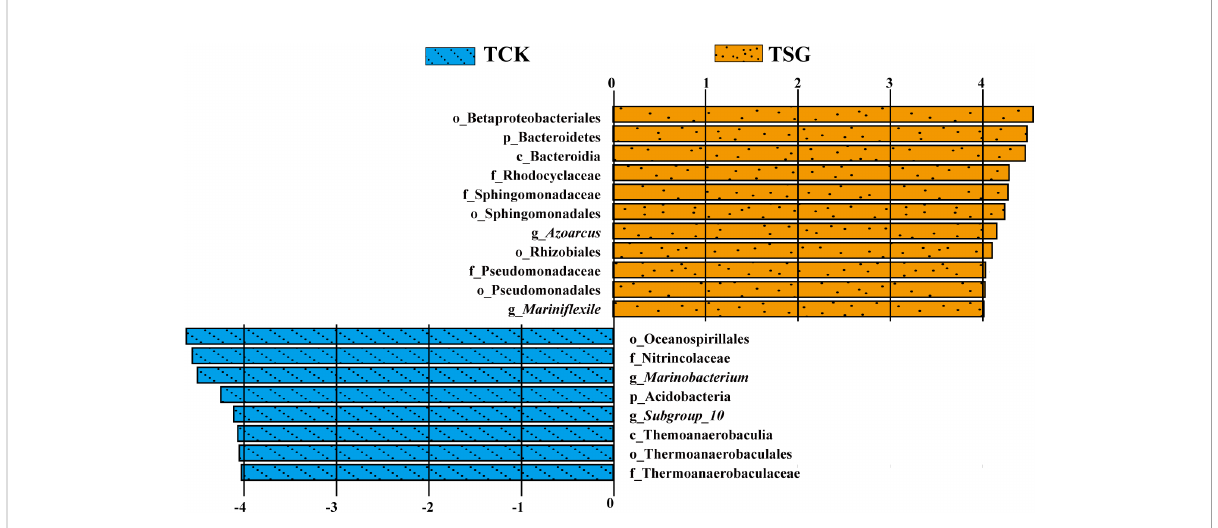
FIGURE 4 Column diagram of LEfSe analysis for two groups of samples ( “ p ” denotes phylum-level; “ c ” denotes class-level; “ o ” denotes order-level; “ f ” denotes family-level; “ g ” denotes genus-level; the length of the columns represents the effect size of the signi fi cantly different species, which is plotted according to the LDA score